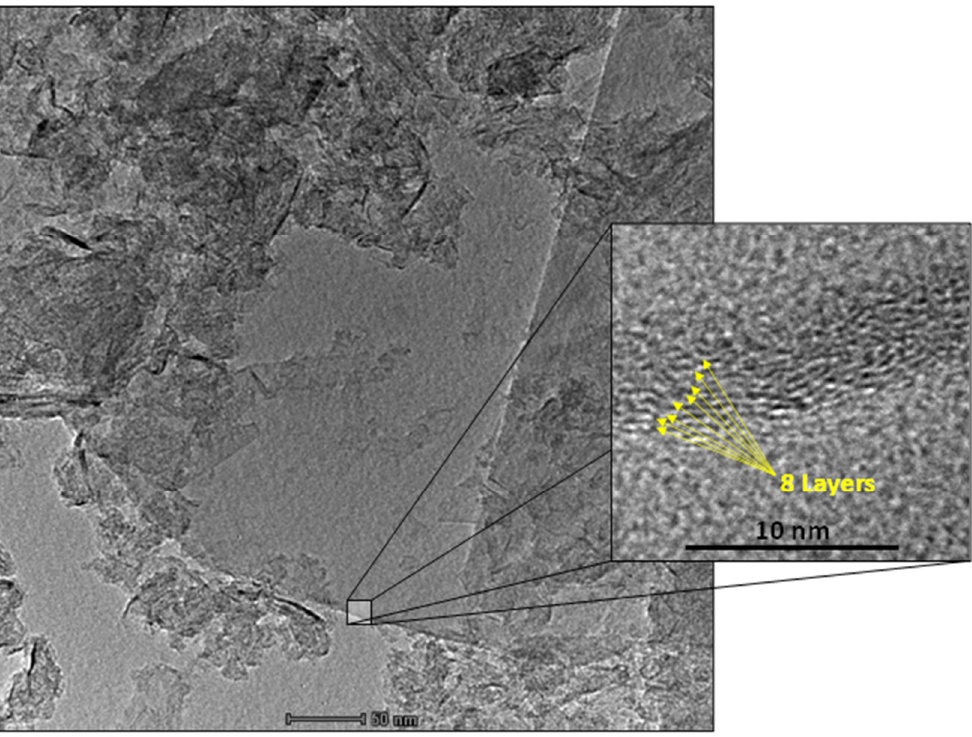
Figure 1. Transmission electron micrographs of graphene nanoplatelets (GNPs). The enlarged image shows the 8 layers of these GNPs.